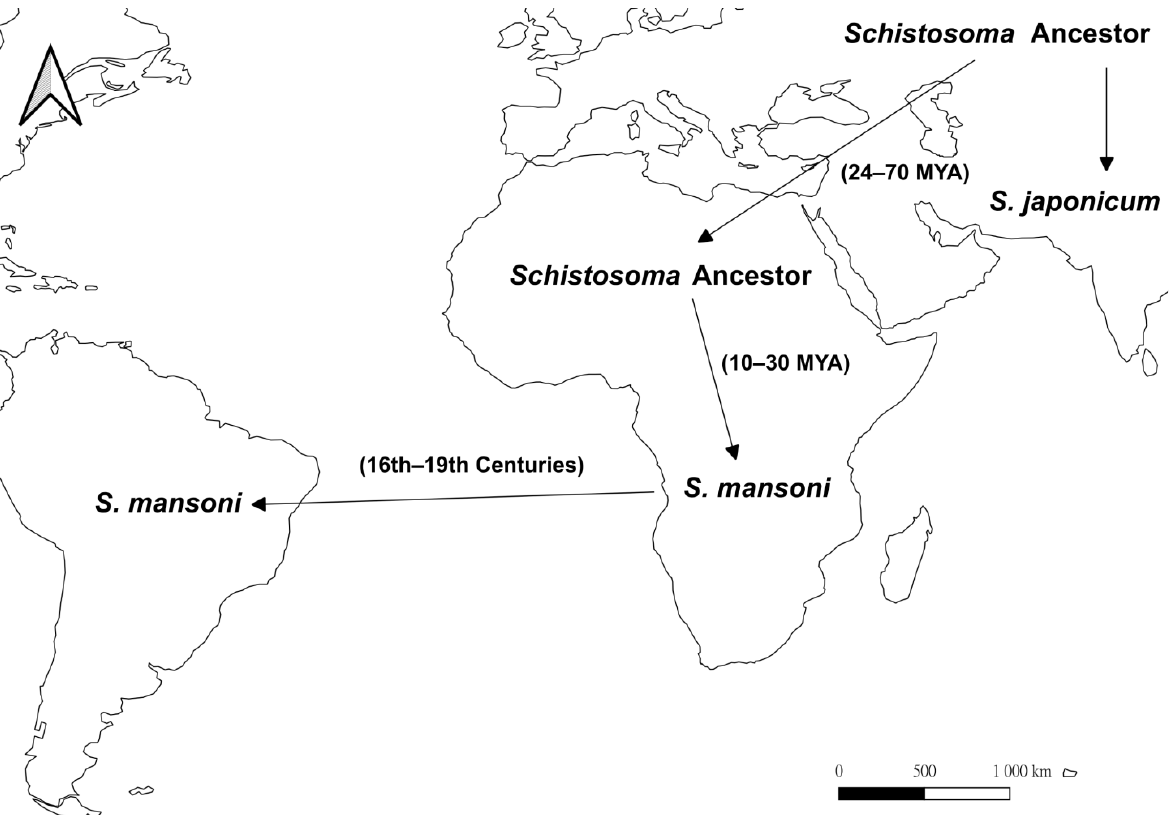
Figure 3. Map showing the proposed evolutionary history of the blood fluke, Schistosoma based on the Asian origin hypothesis (after [58 – 61]). Arrows represent the suggested dispersal directions. In this hypothesis, the ancestor of Schistosoma originated in Asia, migrated to Africa at 24 to 70 mya, and separated into S. mansoni and other Schistosoma species at 10 to 30 mya. Later in the 16th to 19th as slave